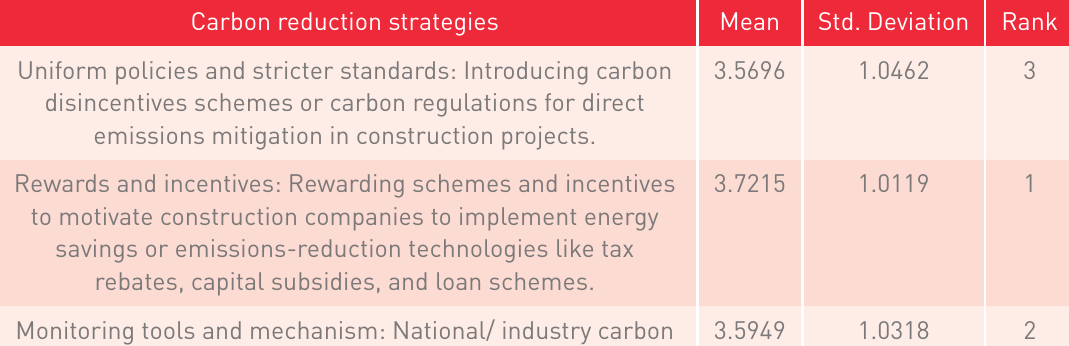
Table 4. Descriptive statistics of the mean (m) and standard deviation (sd) for carbon reduction strategies Carbon reduction